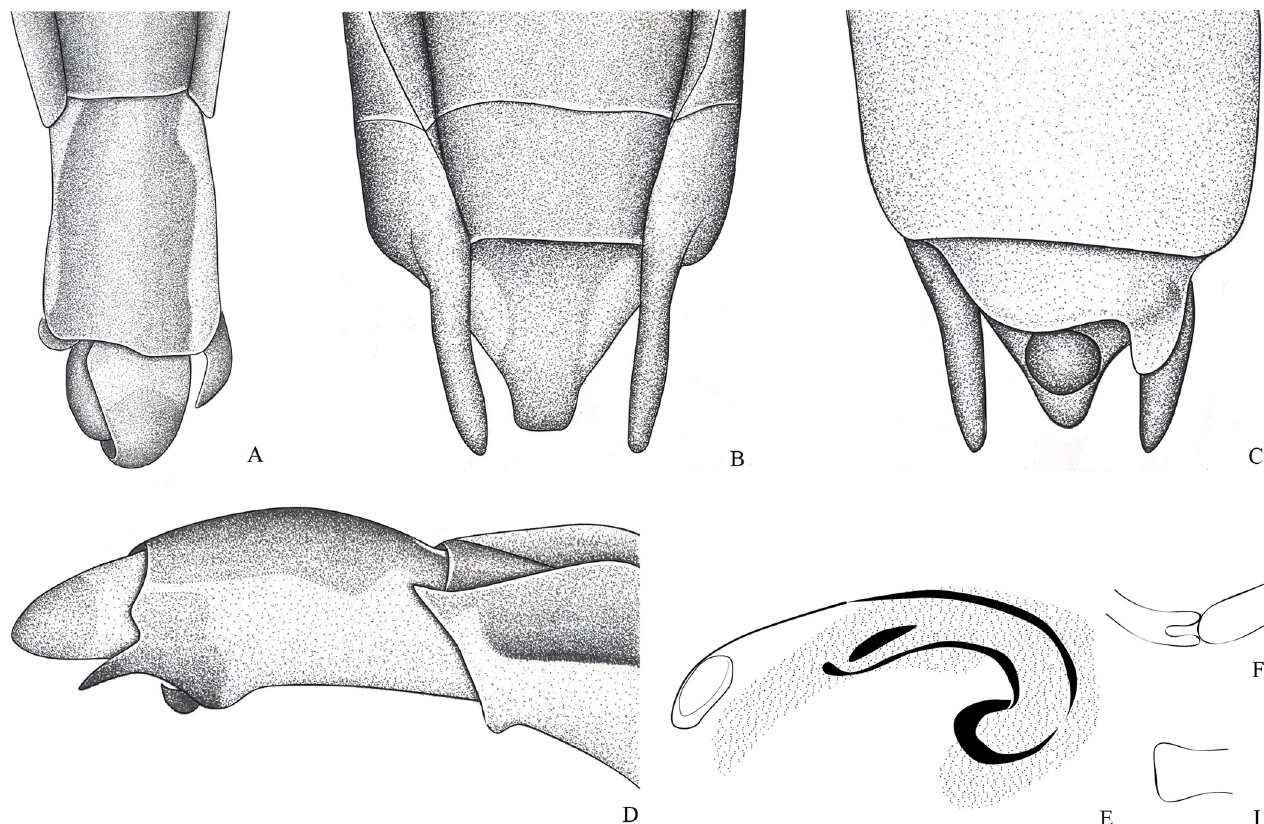
Fig 12. Potamobates peruvianus . (A) Male, terminalia, dorsal view; (B) female, terminalia, dorsal; (C) female, terminalia ventral view; (D) male, terminalia, right lateral view; (E) phallus, lateral view; (F) junction between dorsal and ventral sclerite; (G) base of ventral sclerite.